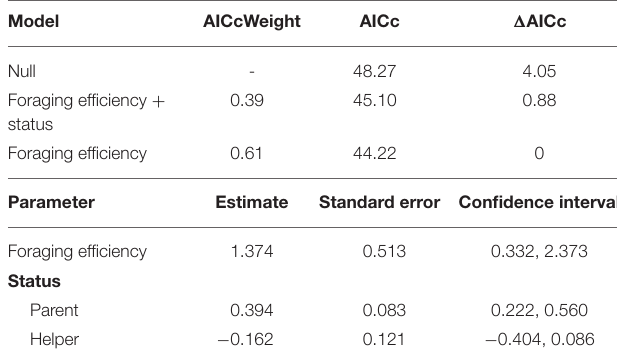
FIGURE 2 | The relationship between chick age (nestling phase 0-4 weeks, fledgling phase 4–8 weeks) and the proportion of time a helper invested in young. Raw data values are displayed against the line of best fit generated from the top model presented in Table 2 .